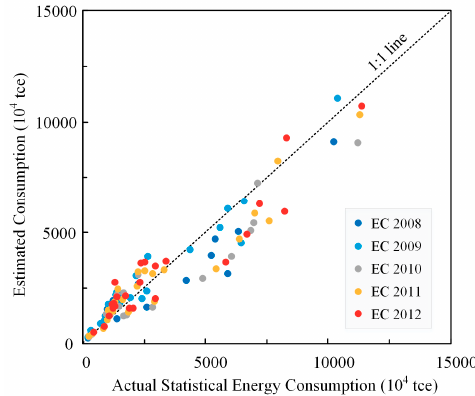
Figure 4. The scatterplot of the actual statistical energy consumption (EC) at the city level, versus the corresponding energy consumption estimated by the linear regression models during the period of 2008–2012.